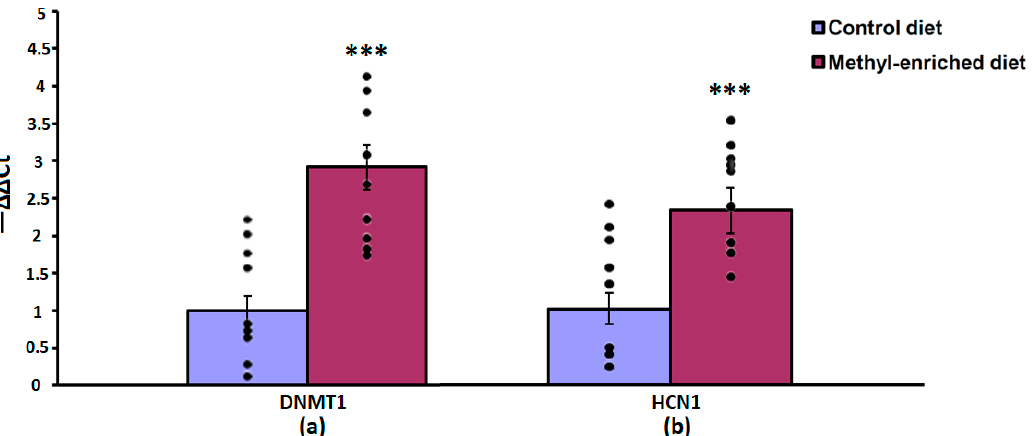
Figure 4. The mRNA expression levels of DNMT1 ( a ) and HCN1 ( b ) genes in the somatosensory cortex in adult offspring of WAG/Rij rats born to mothers fed a methyl-enriched or control diet. Expression of the DNMT1 and HCN1 mRNA were determined by real-time qPCR in 9 pairs of tissue samples from the control ( n = 10 rats) and experimental ( n = 10 rats) group of animals. Data are the mean ± S.E.M. The individual data points are displayed in bar graphs to show within-group variability. ***— p < 0.001 compared with the corresponding values in the control group. In the hippocampus, a maternal methyl-enriched diet increased the mRNA expres- sion levels of DNMT1 [H(1,18) = 12.8, p < 0.01] and HCN1 [H(1,18) = 12.8, p < 0.01] genes